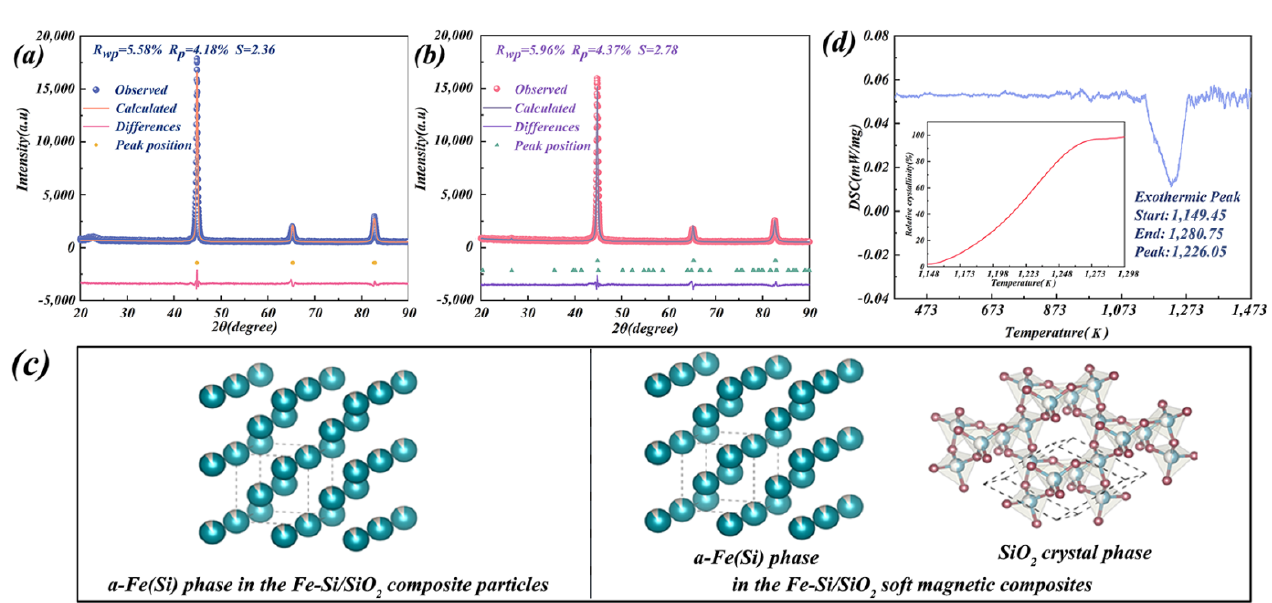
Figure 5. Rietveld refinement patterns of XRD data for ( a ) Fe–Si/SiO 2 composite particles and ( b ) soft magnetic composites; ( c ) schematics of the crystal structure of Fe–Si/SiO 2 composite particles and soft magnetic composites; ( d ) DSC curves and relative crystallinity, as a function of temperature, for Fe–Si/SiO 2 composite particles. Table 1. Crystal refinement data of Fe–Si/SiO 2 composite particles and soft magnetic composites.